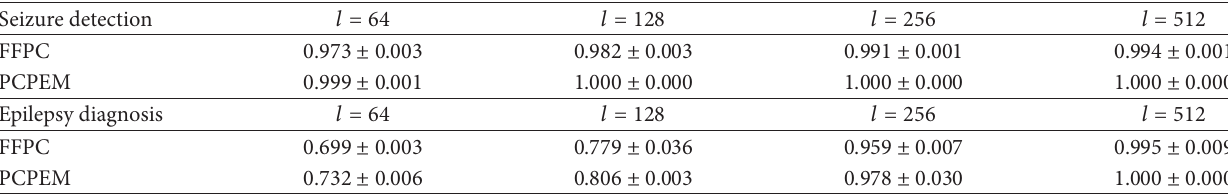
Table 1: The average classification accuracy (i.e., the proportion of all signal types correctly detected) using methods of FFPC and PCPEM with different values of 𝑙 for the epileptic seizure detection and diagnosis problems using the EEGs dataset from the University of Bonn.